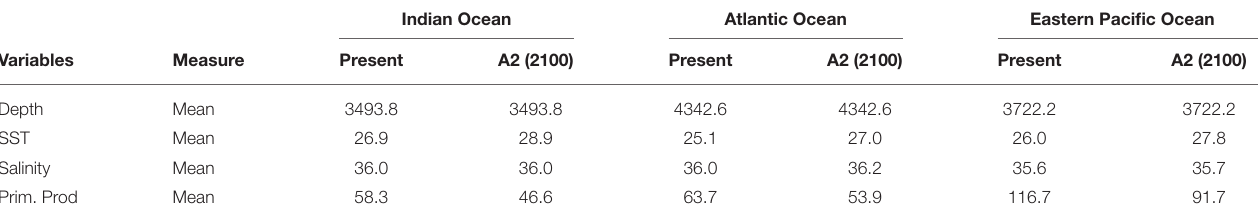
TABLE 2 | Mean of environmental variables in the three oceans considered in this